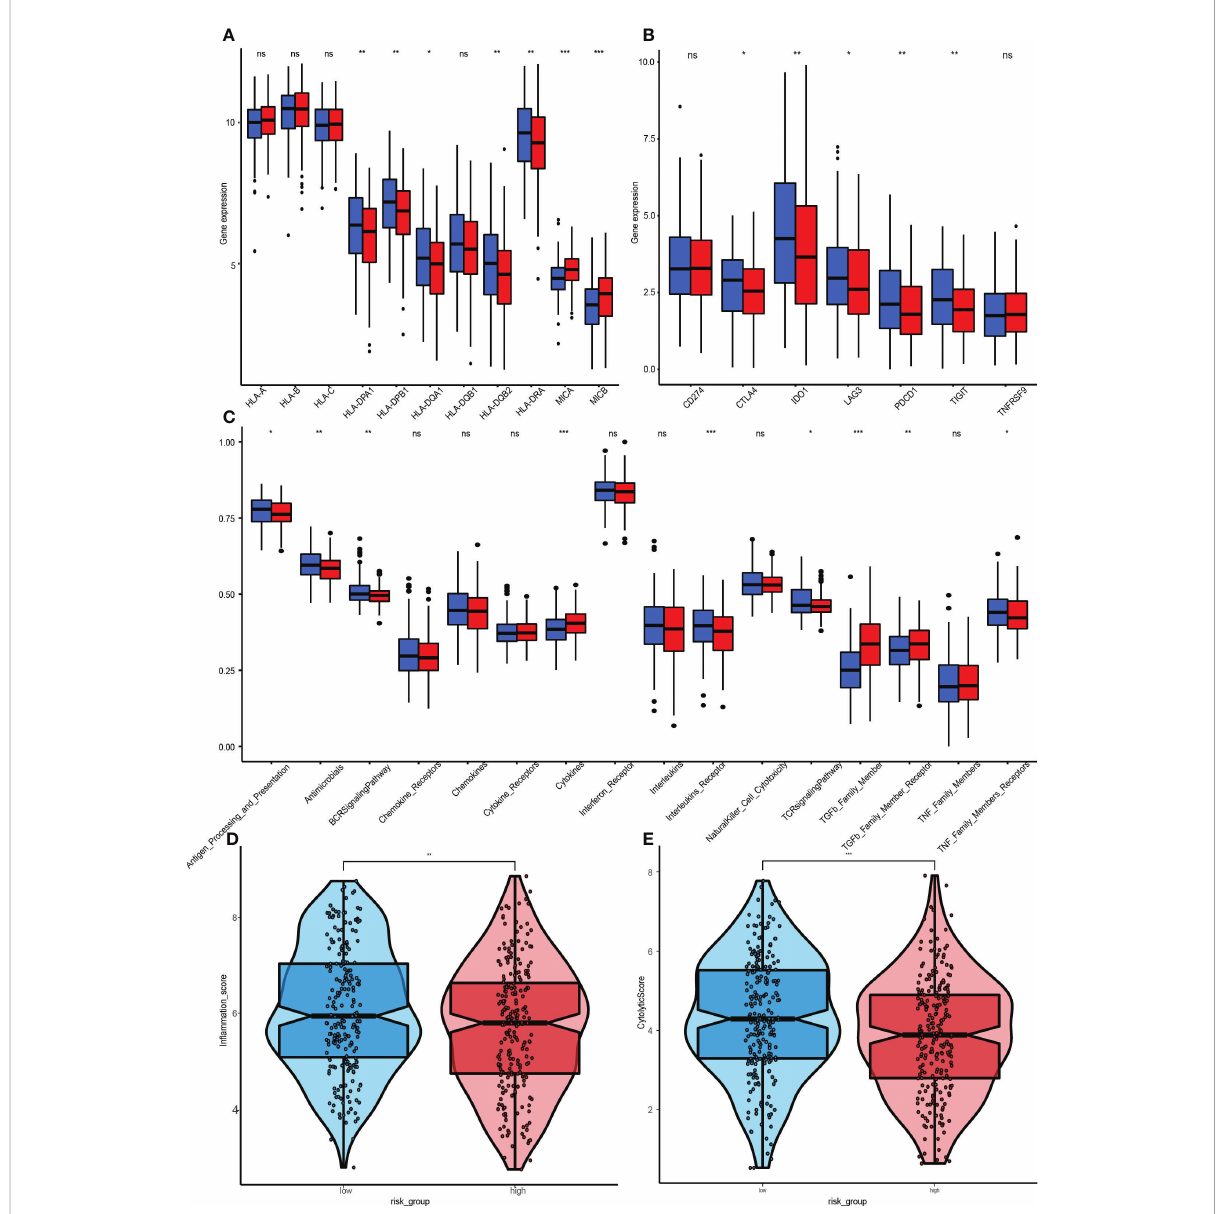
FIGURE 9 Immunization between high and low risk groups. (A) Differential expressions of 11 HLA class immune checkpoints. (B) 7 genes. CD274, CTLA4, IDO1, LAG3, PDCD1, TIGIT, and TNFRSF between the high-GRGPI group and low-GRGPI group. (C) Immune-related pathways. (D, E) Violin diagram for differences in cytolytic activities and Tumor In fl ammation Signature between the high-GRGPI and low-GRGPI groups. (ns, not signi fi cant, *P<0.05, **p < 0.01, **p <